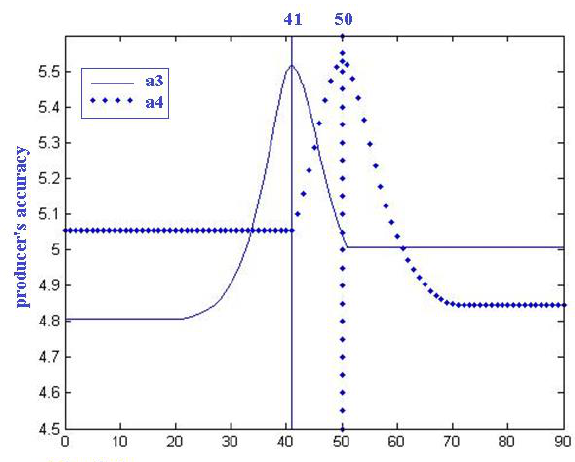
Fig.6. mean producer’s accuracy versus different values of the a3 and a4